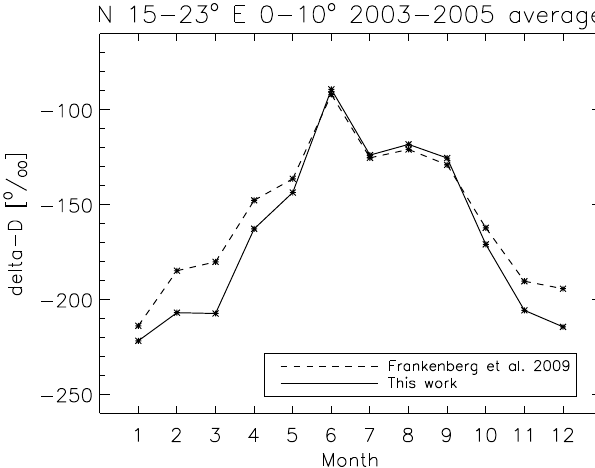
Fig. 11. Impact of the retrieval updates on the seasonality in the Sahel (following Frankenberg et al. (2009); both seasonalities have been shifted by −